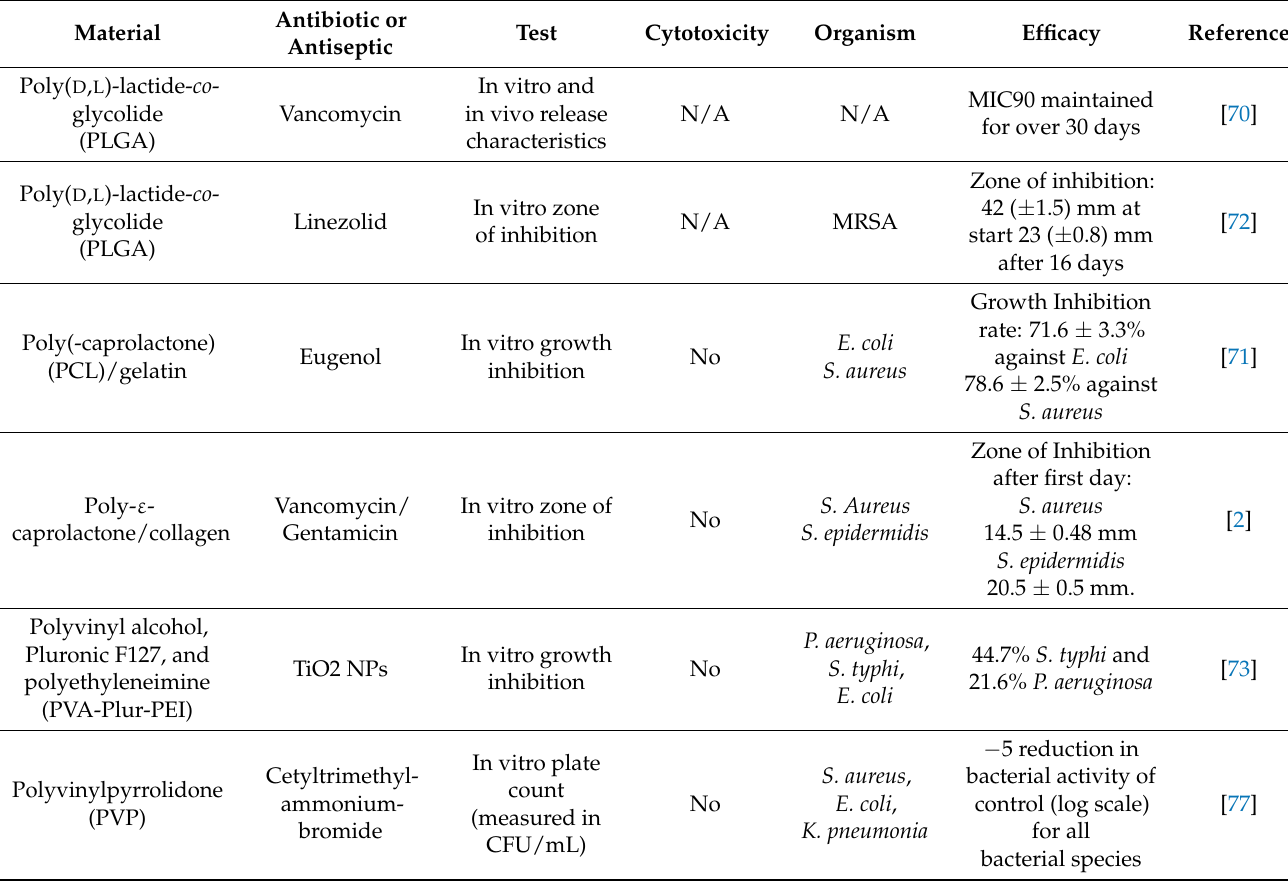
Table 1. Nanofiber approaches to prevent